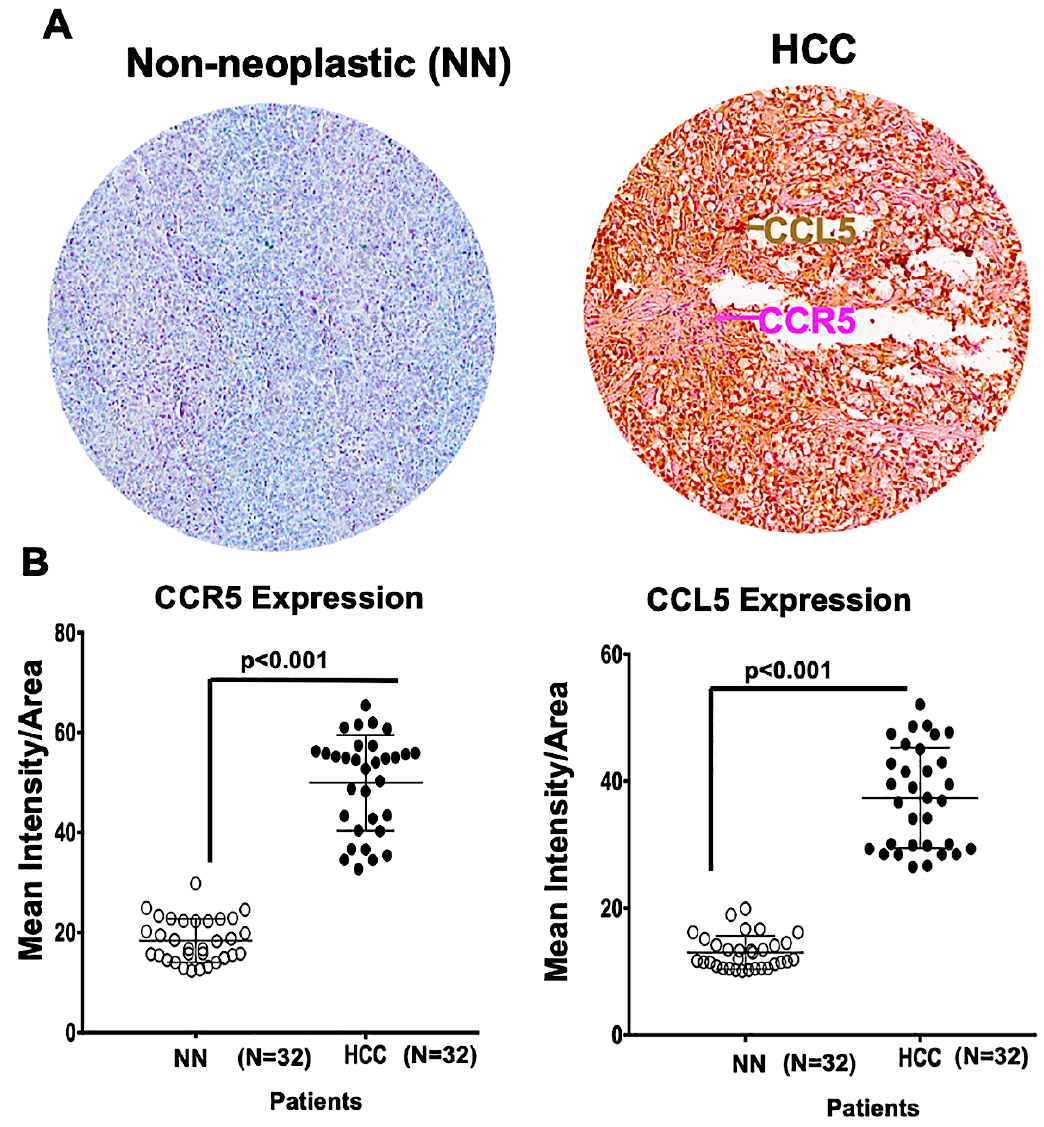
Figure 1. CCR5 and CCL5 are overexpressed in liver cancers (LCas) compared to adjacent tissues. ( A ) Liver tissues from non-neoplastic (NN) areas and hepatocellular carcinomas (HCCs) were stained with anti-CCL5 and anti-CCR5 antibodies. Magenta (AP) and brown (DAB) colors show CCR5 and CCL5 staining, respectively. A 40 × objective was used to capture digital images from the slides. ( B ) Scatter diagrams were used to plot immunointensity scores determined by immunohistochemistry (IHC) of non-neoplastic tissues ( N = 32) and HCCs ( N = 32). Cells were categorized as to stain intensity 0 (blue), 1 + (yellow), 2 + (orange) and 3 + (Red). There were significant differences ( p < 0.001) between HCCs and non-neoplastic tissues.